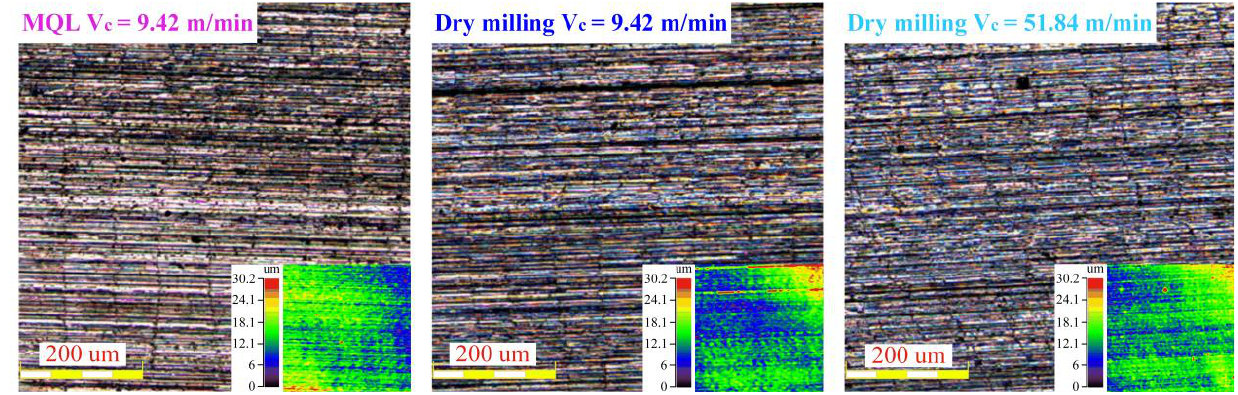
Figure 9. The surface topography of the machined workpiece at different milling speeds.